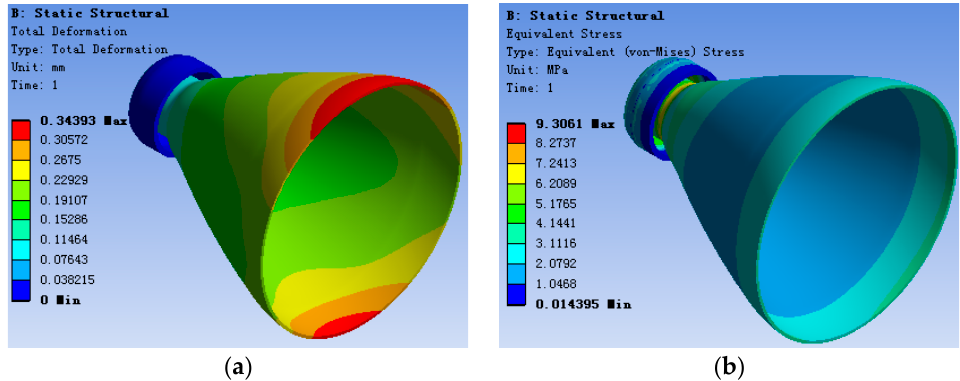
Figure 21. Cloud map of ground nozzle properties. (Ground, 6 MPa.) ( a ) Structure deformation. ( b ) Stress distribution.